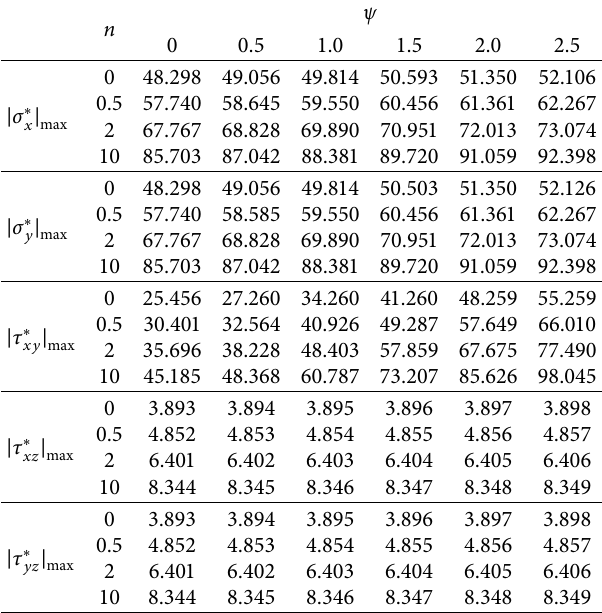
Table 8: Maximum stresses at z � h /2 of fully simply supported FGM nanoplate subjected to uniformly distributed load, a / h � 10, and a / b �